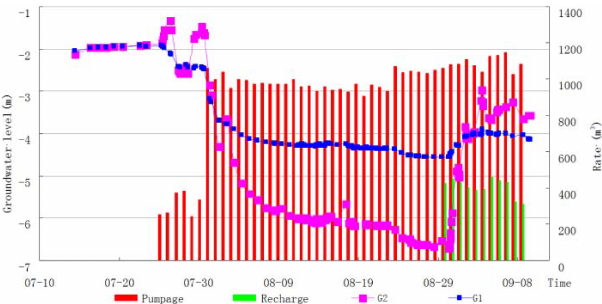
Figure 5. The observation data of groundwater level (G1 is an ob- servation well 60m away from the foundation pit and G2 is an ob- servation well 200m away from the foundation